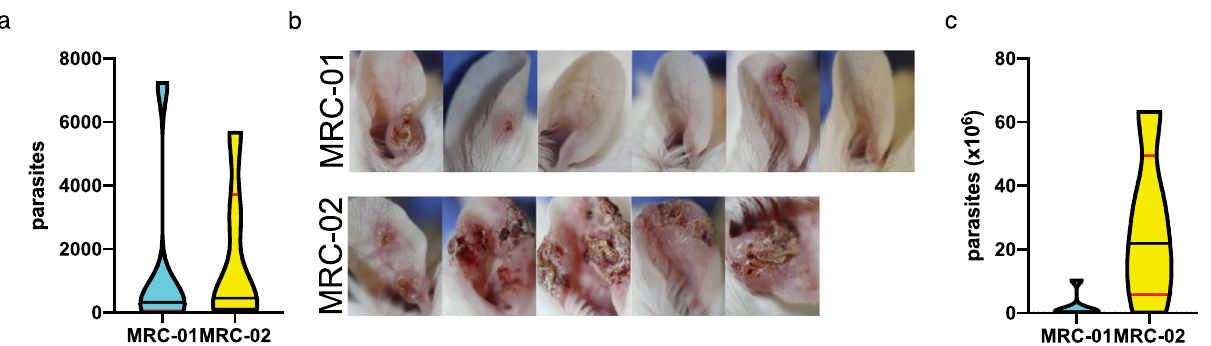
Fig. 7 Transmission of L. major MRC-01 and L. major MRC-02 to BALB/c mice by sand fl y bite. a Parasites loads per ear determined by qPCR immediately post bite. Data are shown as violin plot for n = 6 ears per parasite strain. Additional data found in Supplementary Table 1. b Photographs of ear lesions in individual mice 6 weeks post exposure to sand fl ies infected with L. major MRC-01 and L. major MRC-02. For time-course photographs, see Supplementary Fig. 6. c Parasite loads determined at 6 week post exposure to infected bites. Data are shown as violin plot for n = 5 ( L. major MRC-02) or 6 ( L. major MRC-01) ears per parasite strain. Data are derived from a single transmission experiment. Source data are provided as a Source data